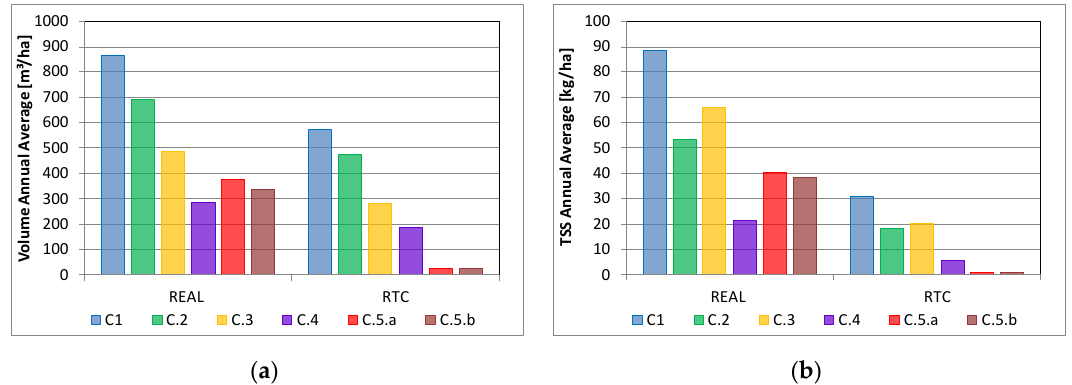
Figure 9. Annual specific runoff volume ( a ) and specific total suspended solids (TSS) ( b ) spilled by the CSO into the receiving water body under C0 (benchmark scenario) and C1 (benchmark scenario + RTC) scenarios.